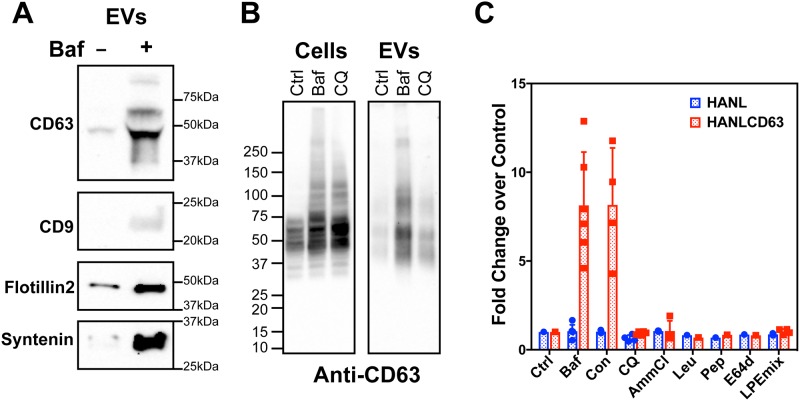
Effects of lysosomal perturbants on EV release.(A) Analysis of EVs collected from naïve HEK293 cells treated with DMSO vehicle (-) or 200nM bafilomycin (+). PEG pellets from conditioned media collected over 5 hours were immunoblotted for CD63, CD9, flotillin 2 and syntenin as markers of EVs. (B) HEK293 cells were treated with vehicle (Ctrl), 200nM bafilomycin (Baf) or 50μM chloroquine (CQ). Cell lysates (Cells) or PEG pellets of conditioned media (EVs) were immunoblotted for CD63. (C) TRex293 cells expressing HANL or HANLCD63 were treated with indicated compounds to inhibit various aspects of lysosome function. Nluc activity was measured in conditioned media and expressed as fold change over vehicle treated (Ctrl) samples. Compounds used include–(i) V-ATPase inhibitors: Baf (200nM Bafilomycin); Con (100nM Concanamycin); (ii) weak bases: CQ (50μM Chloroquine); AmmCl (2mM Ammonium Chloride); (iii) protease inhibitors: Leu (2.5μM Leupeptin); Pep (15μM Pepstatin); E64d (20μM E64d); LPE mix (2.5μM Leupeptin, 15μM Pepstatin, 20μM E64d).